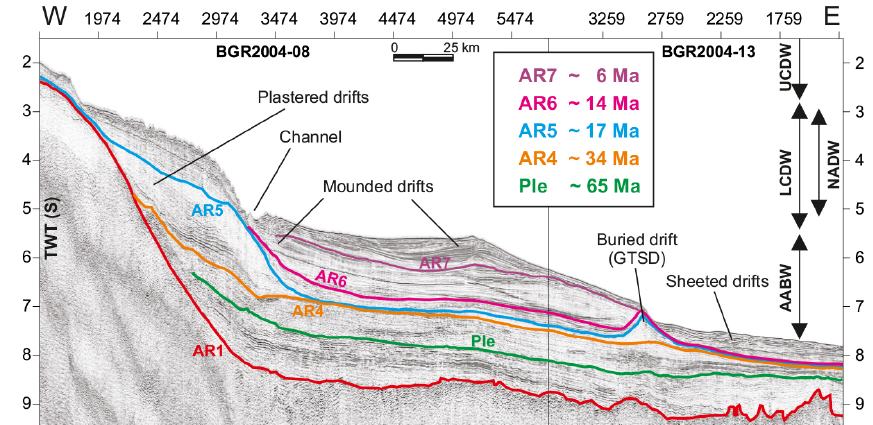
Figure 4. Interpreted seismic line across the Argentine margin featuring distinct drift deposits, channels, and thickness of deposits. Ocean current distribution within the water column: AABW is Antarctic Bottom Water; LCDW is Lower Circumpolar Deep Water; UCDW is Upper Circumpolar Deep Water; NADW is North Atlantic Deep Water (see Grützner et al., 2012). Predicted age and character of the sediment deposits need to be determined through sampling to understand in detail the evolution of the margin in response to climate